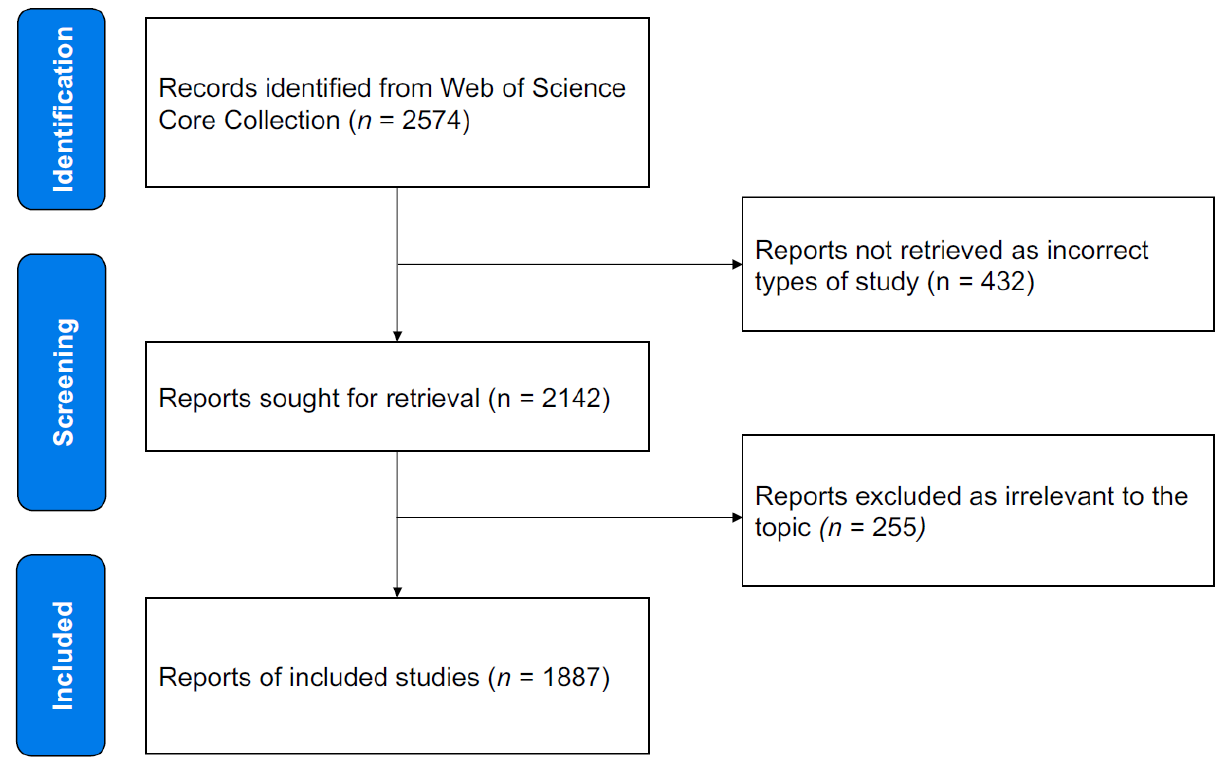
Figure 1. Flow chart of adapted sport studies inclusion.